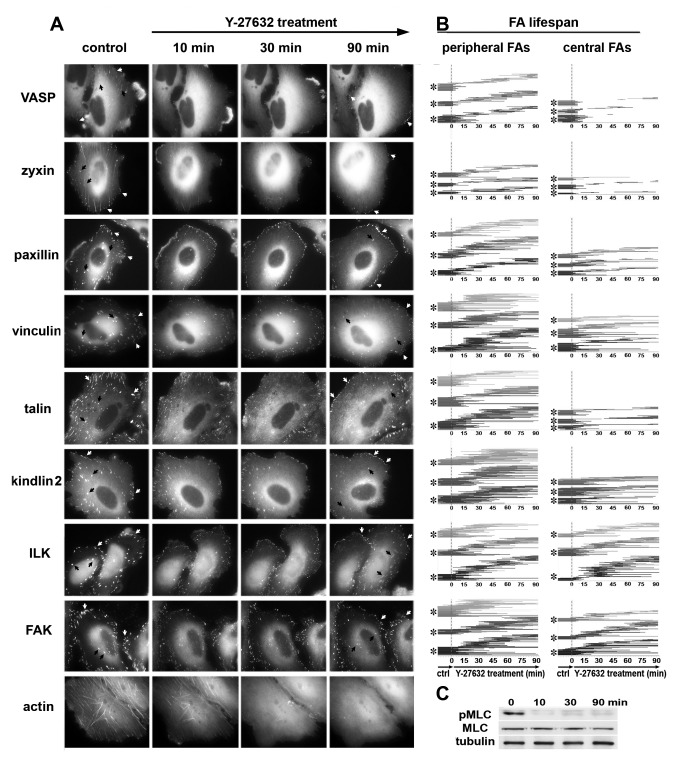
Effect of Y-27632 treatment on FA reorganization in HeLa JW cells.(A) Localization of GFP-tagged VASP, zyxin, paxillin, vinculin, talin, kindlin-2, ILK and FAK in untreated cells (control) or in the cells treated with 10 µM Y-27632 for 10, 30 or 90 min (shown are snapshots from time-lapse movies). White and black arrowheads point to peripheral and central adhesions, respectively.(B) FA lifespan in three different cells tagged by each of the tested proteins prior to and during Y-27632 treatment, as tracked by time-lapse video microscopy. Each line marks the lifespan of an individual adhesion site, from its formation until its complete disassembly. Individual cells are marked by asterisks on the Y axes. The vertical dashed line marks the beginning of the Y-27632 treatment. Peripheral and central FAs were analyzed separately. Note the decay of existing FAs and formation of novel FAs during Y-27632 treatment.(C) Western blots showing MLC and pMLC in untreated cells, or in cells treated with 10 µM Y-27632 for 10, 30 and 90 min Tubulin was used here as a loading control.